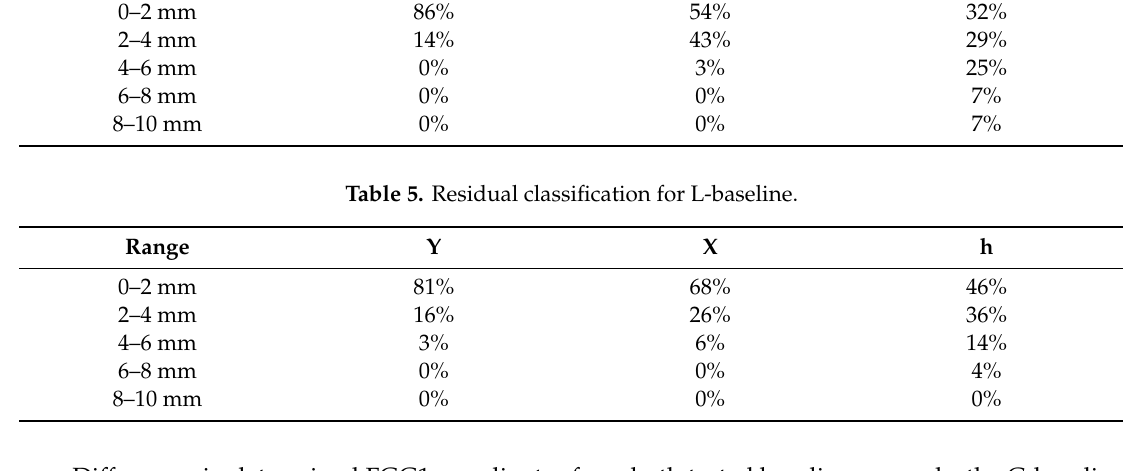
Table 5. Residual classification for L-baseline.